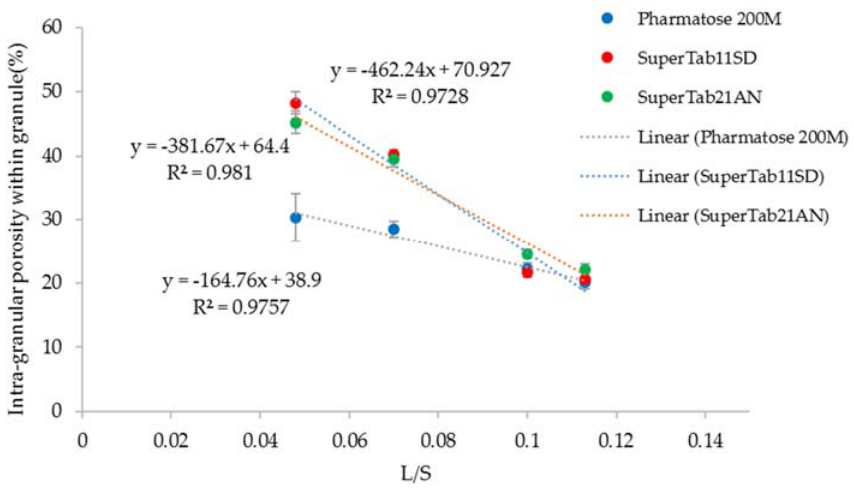
Figure 10. Porosity of granules for different grades of lactose powder at varying L/S (screw speed, 450 rpm).